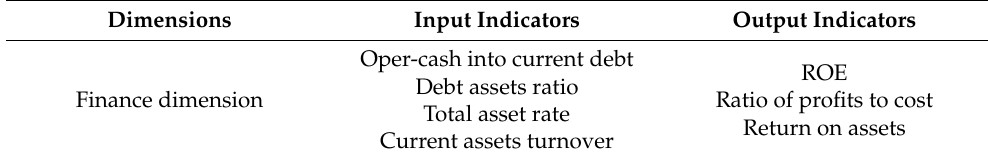
Table 3. Finance dimension evaluation index